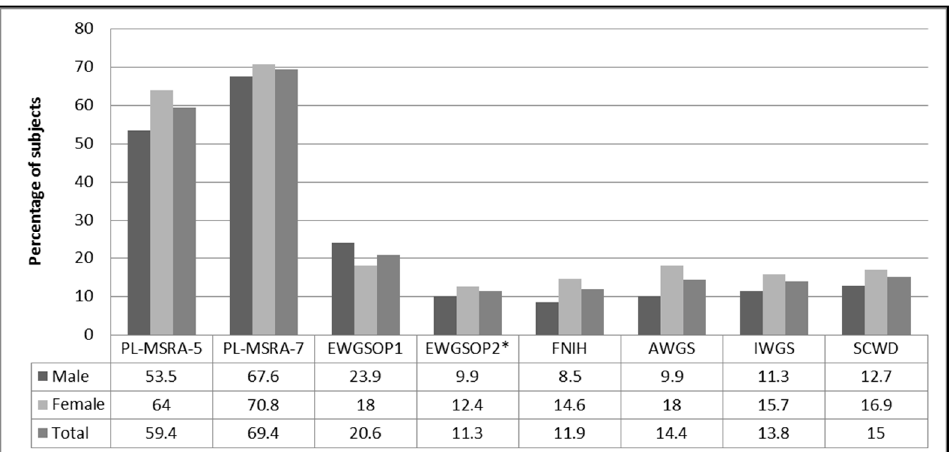
Figure 1. Prevalence rate (%) of sarcopenia according to the PL-MSRA and six sets of international diagnostic criteria for sarcopenia. Notes: * sarcopenia confirmed; Abbreviations: MSRA, Mini Sarcopenia Risk Assessment; EWGSOP1, the European Working Group on Sarcopenia in Older People 1; EWGSOP2, extended group for the European Working Group on Sarcopenia in Older People; FNIH, the Foundation for the National Institutes of Health; AWGS, Asian Working Group on Sarcopenia; IWGS, the International Working Group on Sarcopenia; SCWD, the Society on Sarcopenia, Cachexia and Wasting Disorders.